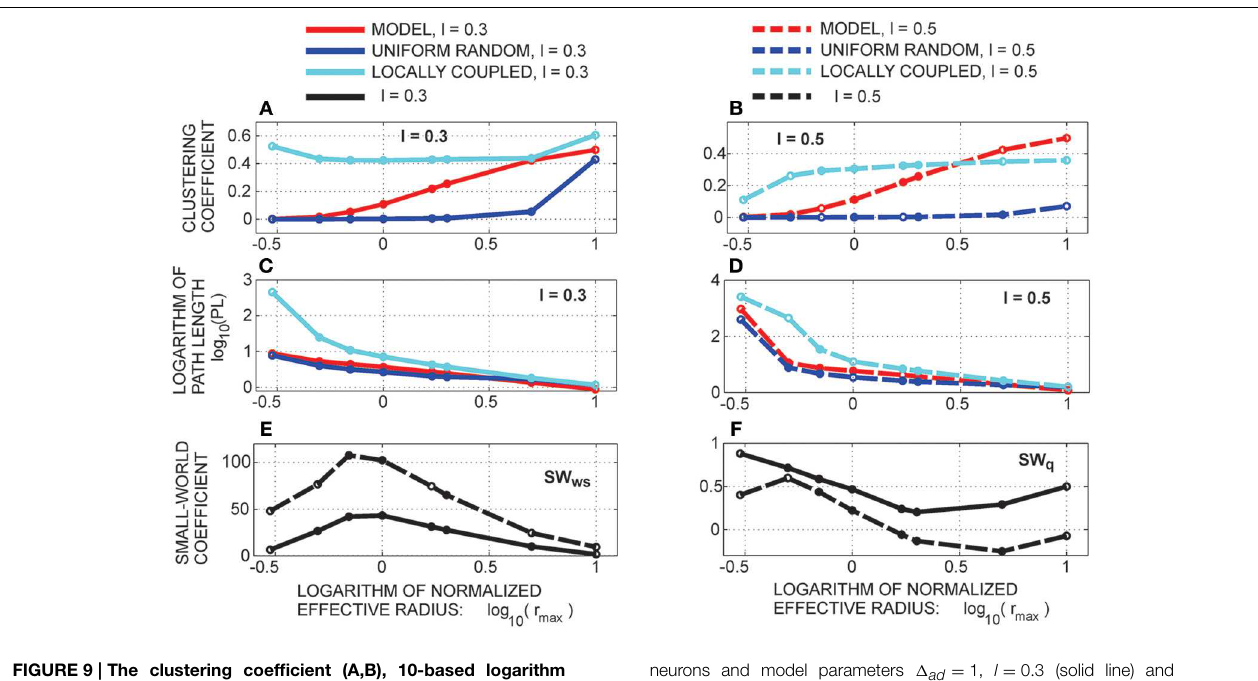
neurons and model parameters 1 ad 1 , l 0 . 3 (solid line) and = = l 0 . 5 (dashed line). Red line, our model; blue, uniform random = networks; turquoise, locally coupled networks with 10% of non-local connections. The x axis shows the logarithm of 10 of the normalized effective radius ( r max ), y axis gives the considered network measures or their 4900 =